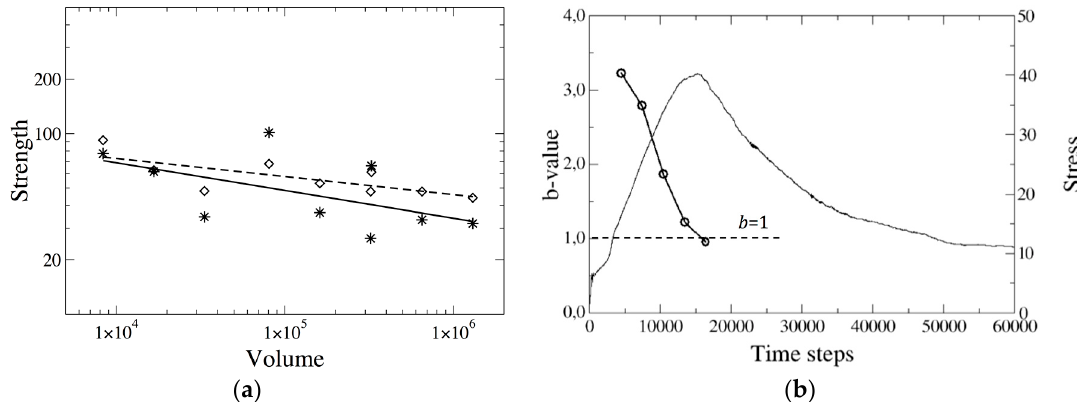
Figure 16. ( a ) Comparison between numerical results (stars and continuous line) and experimental size effect on compression strength (diamonds and dotted line); ( b ) comparison between the stress level and the variation of the simulated b ‐ value (circles) as a function of time.